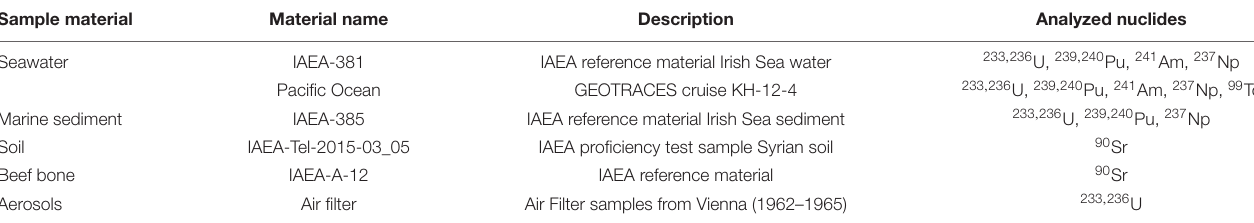
TABLE 1 | Summary of sample materials and radionuclides investigated within the scope of the present